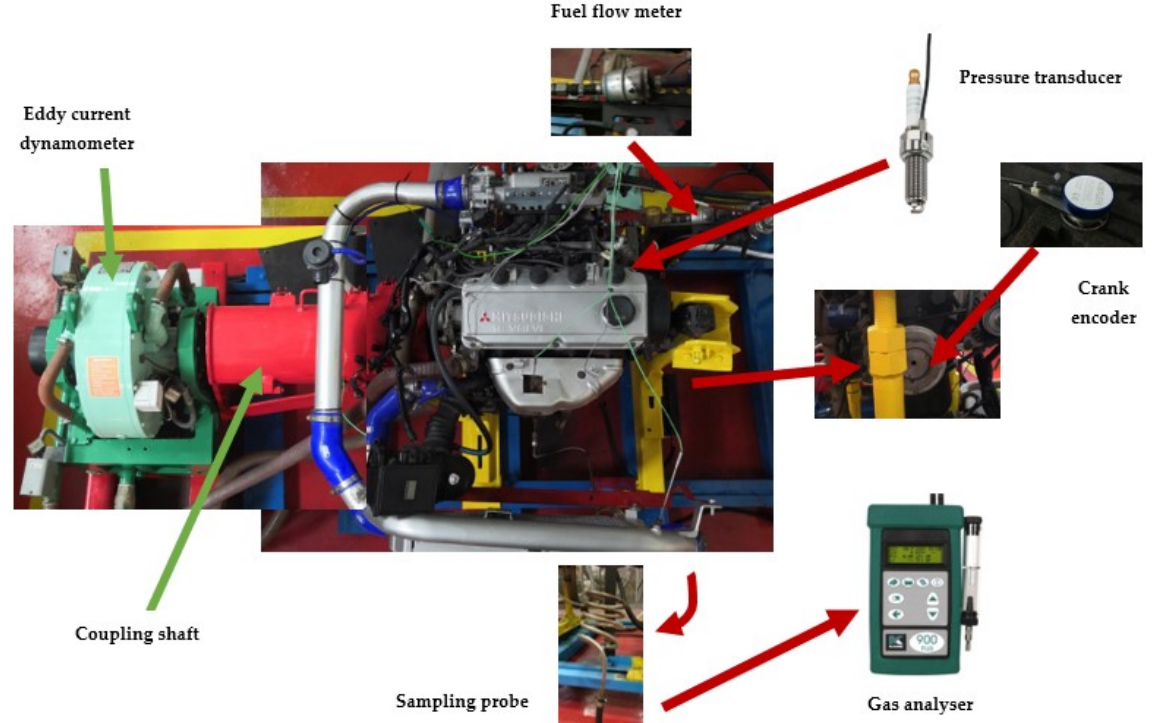
Figure 6. Typical experimental setup for engine performance, combustion, and emissions